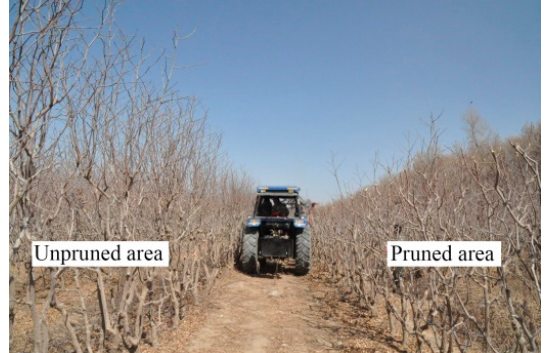
Figure 12. Field validation test.